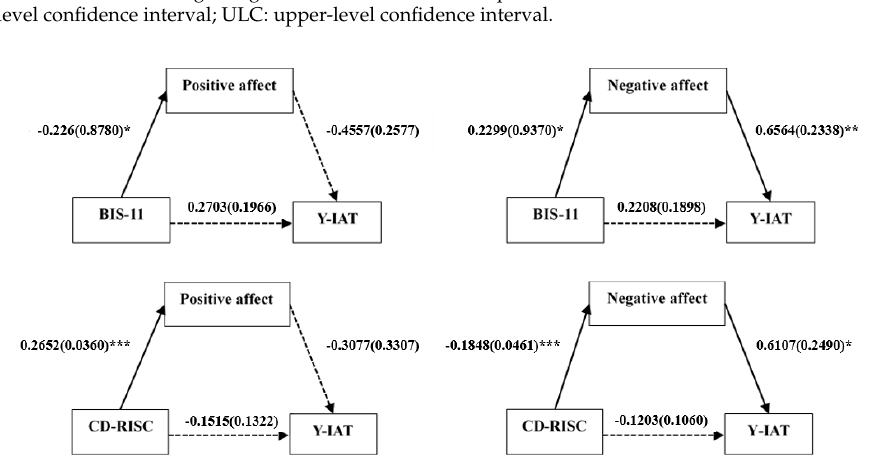
Figure 1. Mediation effects of affect status on the relationship between impulsivity or resilience and the severity of internet gaming disorder (IGD) symptoms in the patient group. Unstandardized coefficients are presented with standard errors in parentheses. * p < 0.05, ** p < 0.01, *** p < 0.001. Y-IAT: Young’s internet addiction test; BIS-11: Barratt impulsiveness scale-11; CD-RISC: Connor-Davidson resilience scale . Table 3. Model of mediation analysis of affect status between impulsivity or resilience and severity of IGD symptoms in the IGD group.